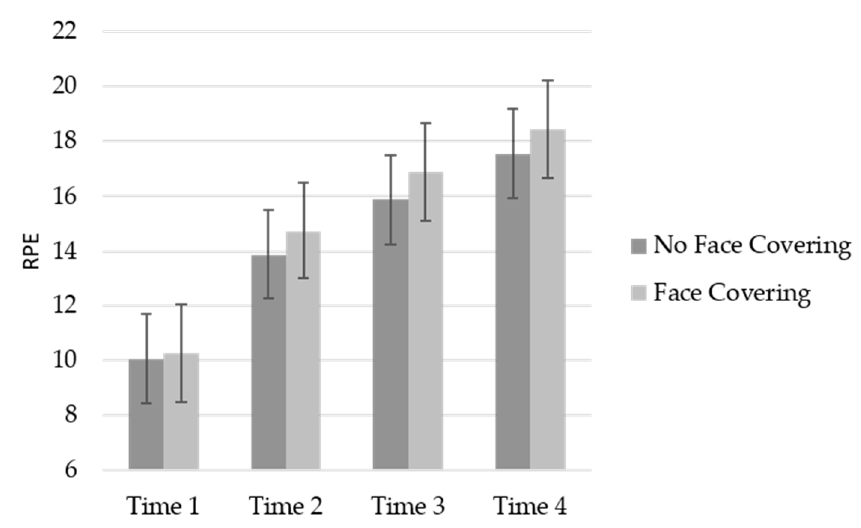
Figure 2. Mean RPE across time by condition.